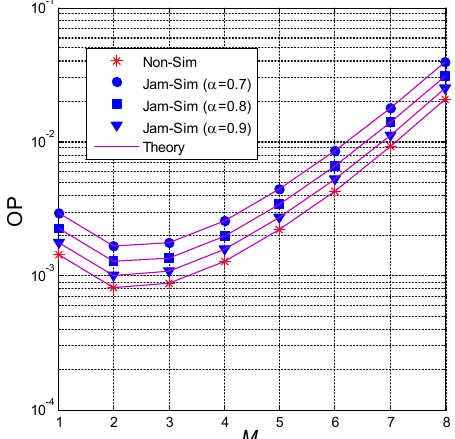
Figure 4 . OP as a function of M when 20dB, D=